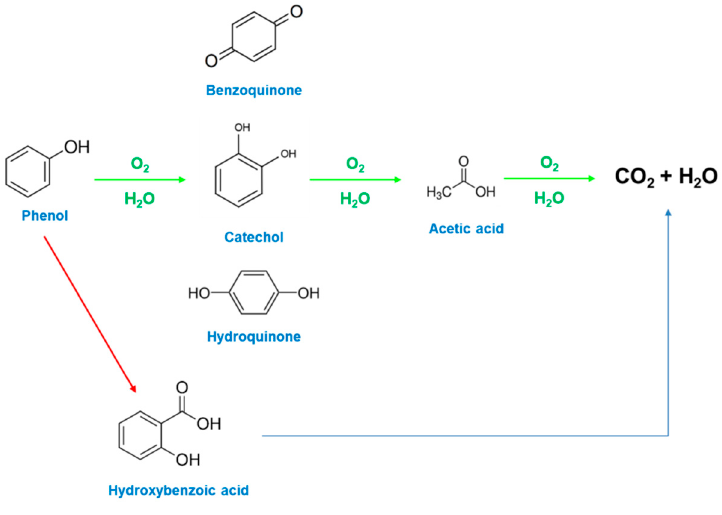
Figure 10. Scheme of phenol wet air oxidation.